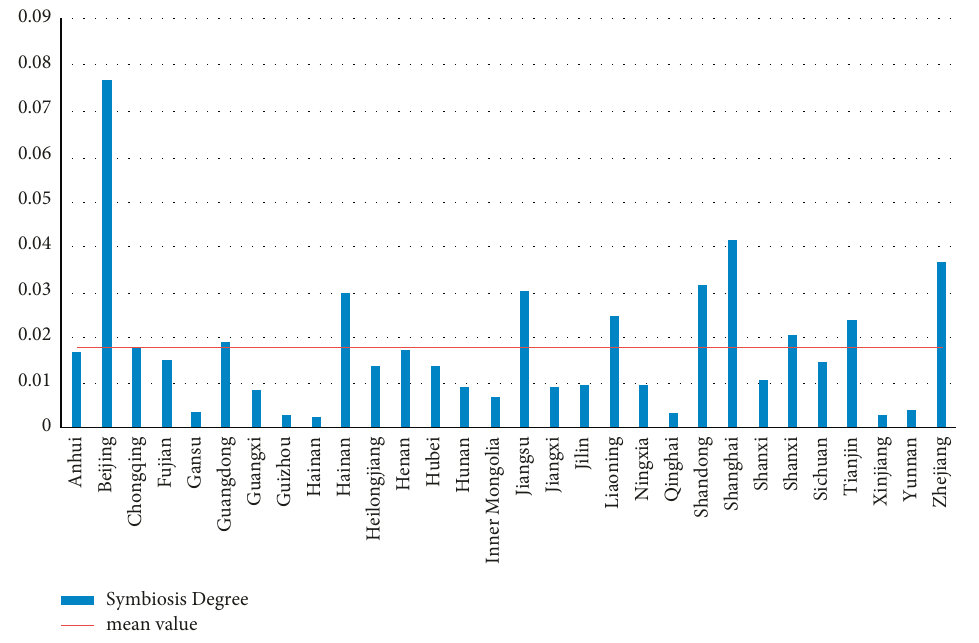
Figure 3: Symbiotic degree of 30 high-tech industry innovation ecosystem in China. Table 1: Comparison of symbiotic efficiency between considering and without considering the influencing factors. Without considering the Considering the Without considering the Considering the Region Region influencing factors influencing factors influencing factors influencing